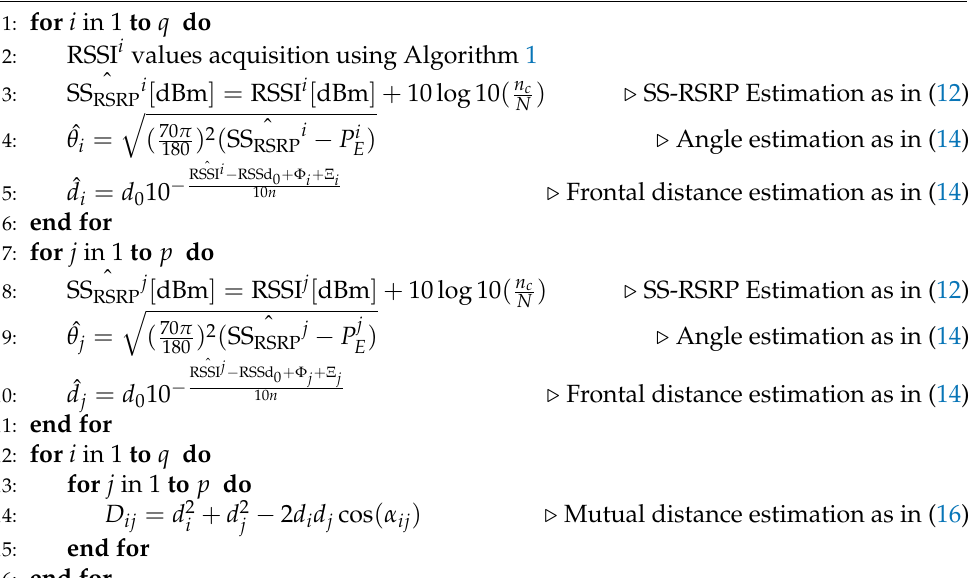
Algorithm 2 Distance Estimation in 5G NR